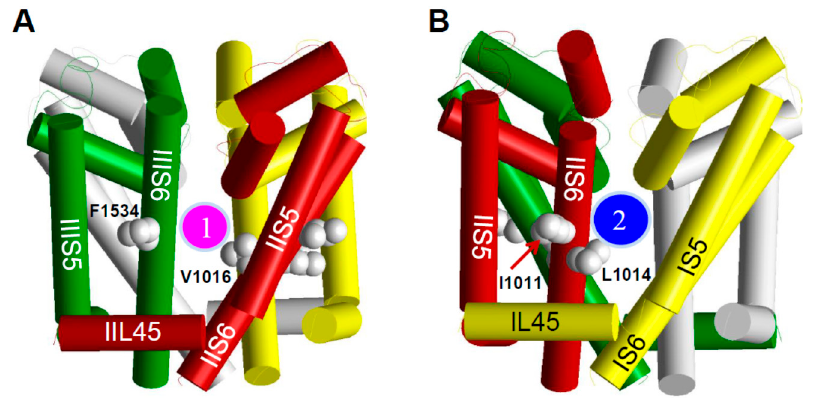
Figure 3. Cont. Figure 3.